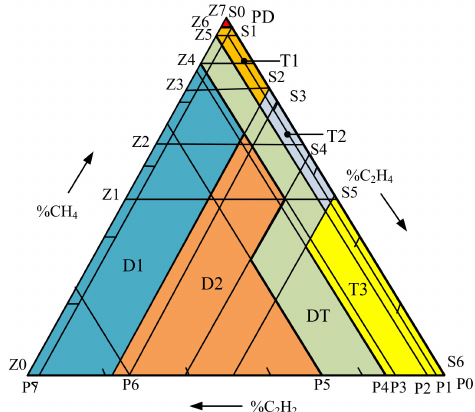
Figure 6. Fuzzy Logic Zoning in Duval Triangle.